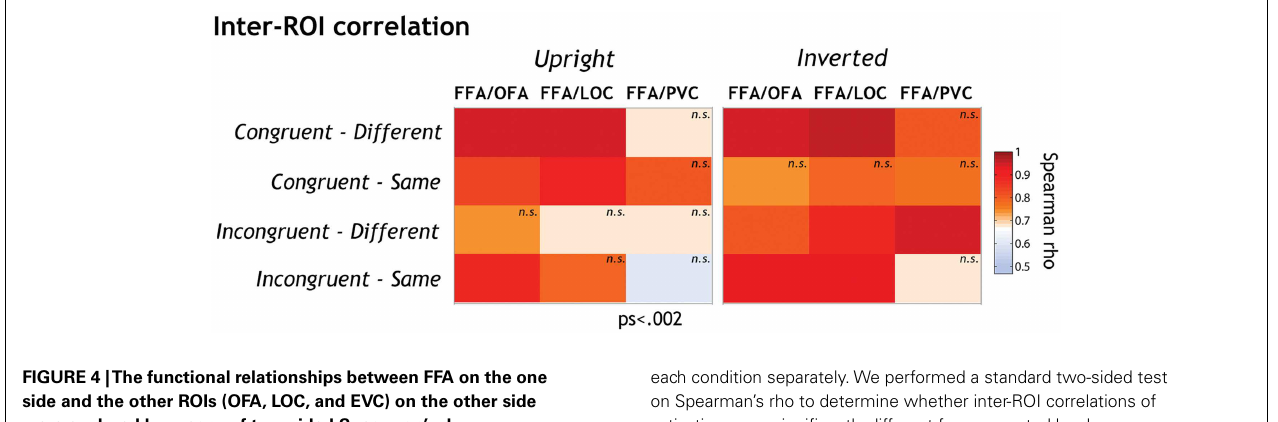
FIGURE 4 |The functional relationships between FFA on the one side and the other ROIs (OFA, LOC, and EVC) on the other side were explored by means of two-sided Spearman’s rho correlation analyses (alpha level corrected for multiple analyses: 0.002). Spearman rho coefficients are color-coded for